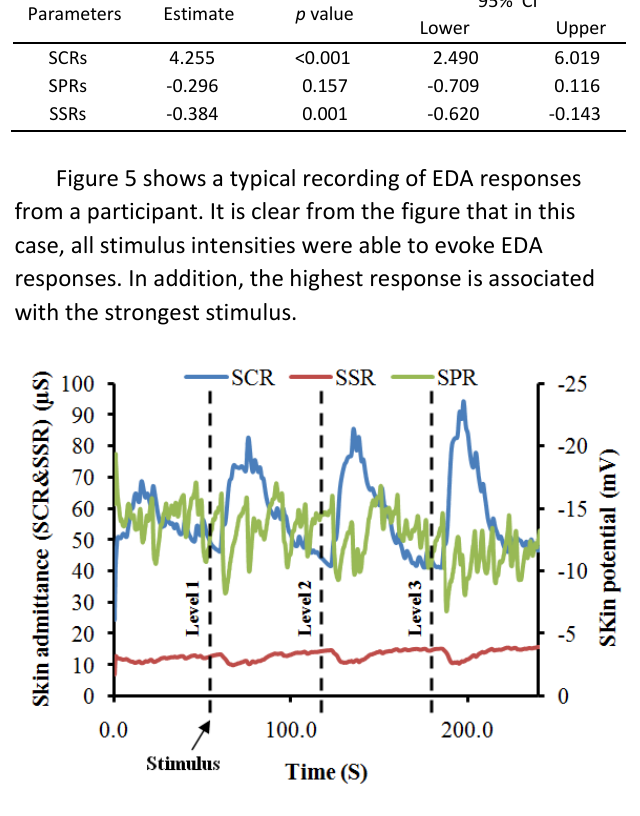
Fig. 5: A typical EDA recording from a participant, demonstrating changes in EDA responses with respect to painful stimuli.